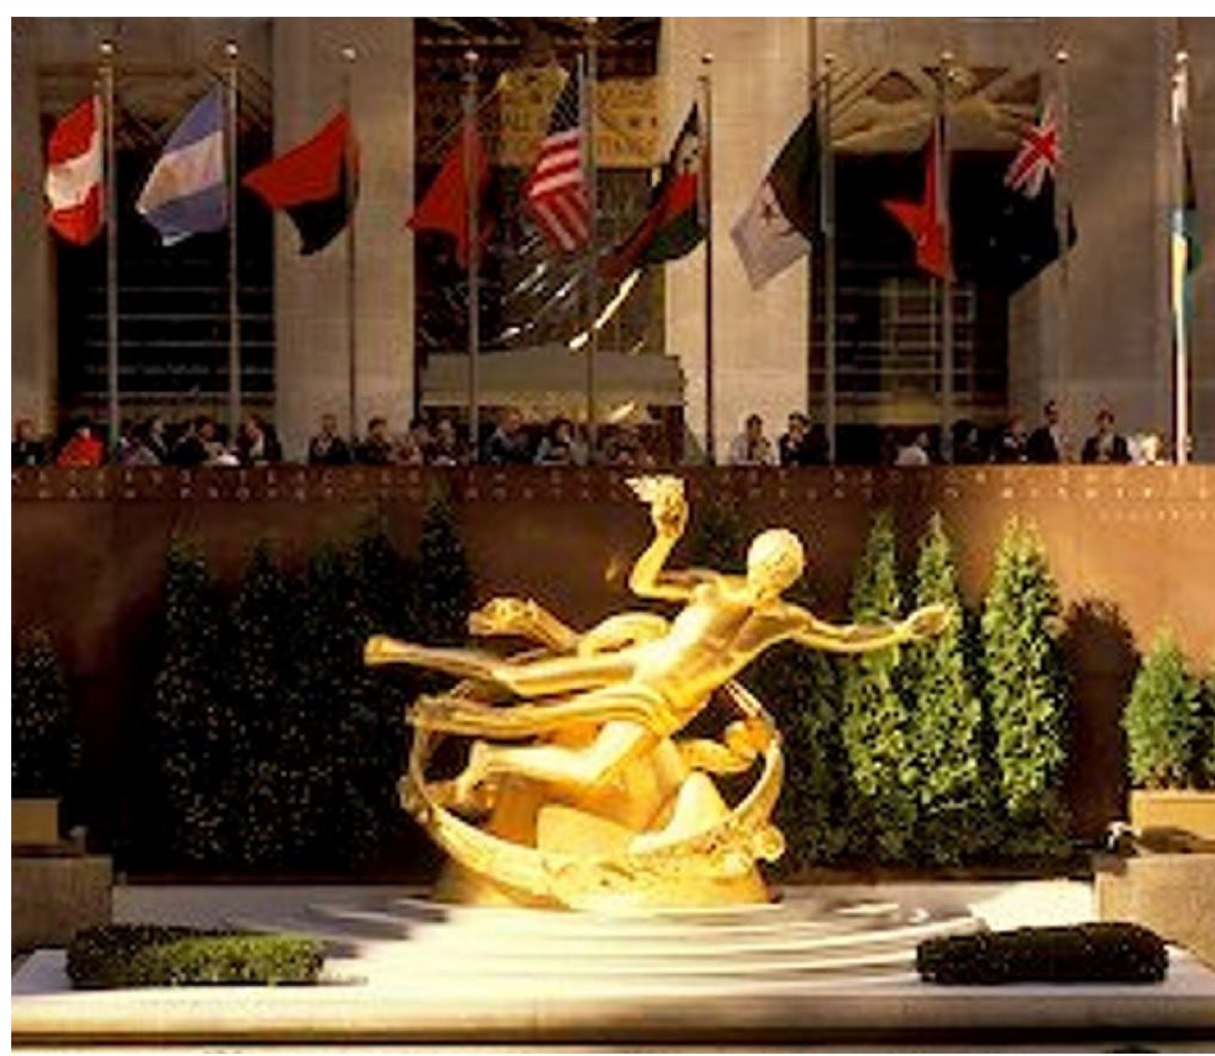
Figure 1. The statue of Prometheus at Rockefeller Center in New York City (Photograph by the